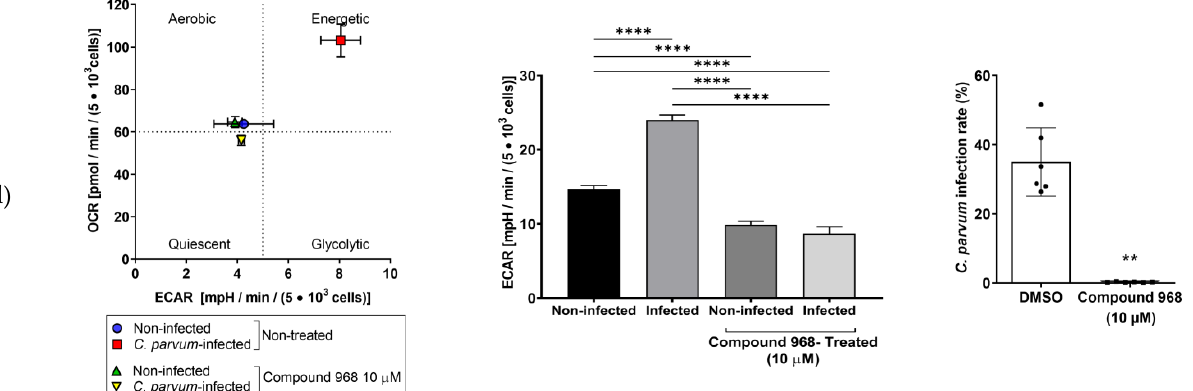
Figure 9. Impact of C. parvum infection and inhibitor treatments on HCT-8 energetic profiles: (First column) The current energetic profiles are plotted by presenting OCR- and ECAR values in HCT-8 ( n = 3, each condition). (Second column) Effect of galloflavin ( a ), lonidamine ( b ), syrosingopine ( c ) and compound 968 ( d ) treatments on energetic profiles of HCT-8 infected and non-infected controls: The glycolytic function was evaluated in C. parvum -infected host cells under 21% O 2 by means of Seahorse Glycolysis Stress Test. Glycolytic activities in treated and infected cells were compared with untreated and infected cells, revealing a significant reduction in glycolytic capacity. (Third column) Thus, reduced glycolytic capacity corresponds with significant reduction of infection rates. Bars present means ± SD, (Energy maps, First column, n = 3; Glycolysis, second column n = 3, Infection rates, third column, n = 6). For evaluation of significance on glycolytic function (second column) one-way analyses of variance (ANOVA) followed by Dunnett’s test was performed. Significances of inhibitors effects on infection rates (third column) were estimated by means of t -test. * = p ≤ 0.05, ** = p ≤ 0.01, *** = p ≤ 0.001, **** = p ≤ 0.0001.